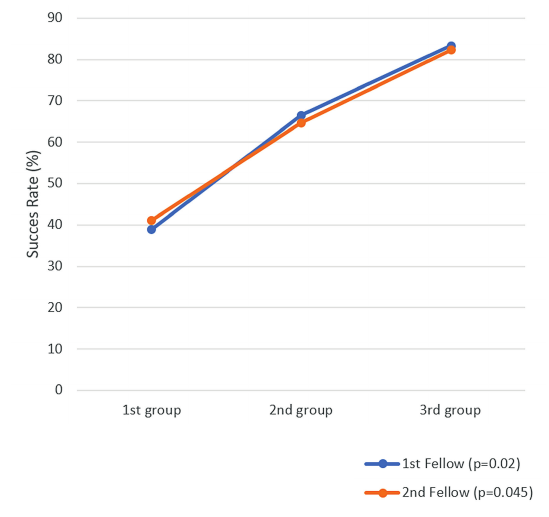
Figure 1 - variation in EI success rates of all patients according to groups.